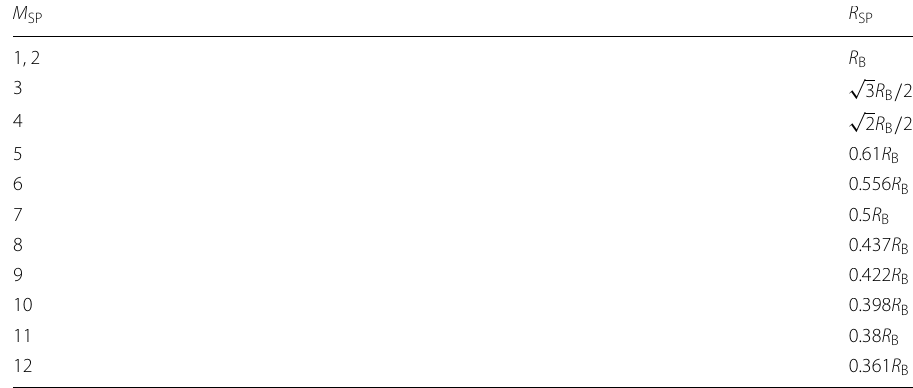
Table 1 The number of stop points M SP and the serving range R SP M SP R SP 1,